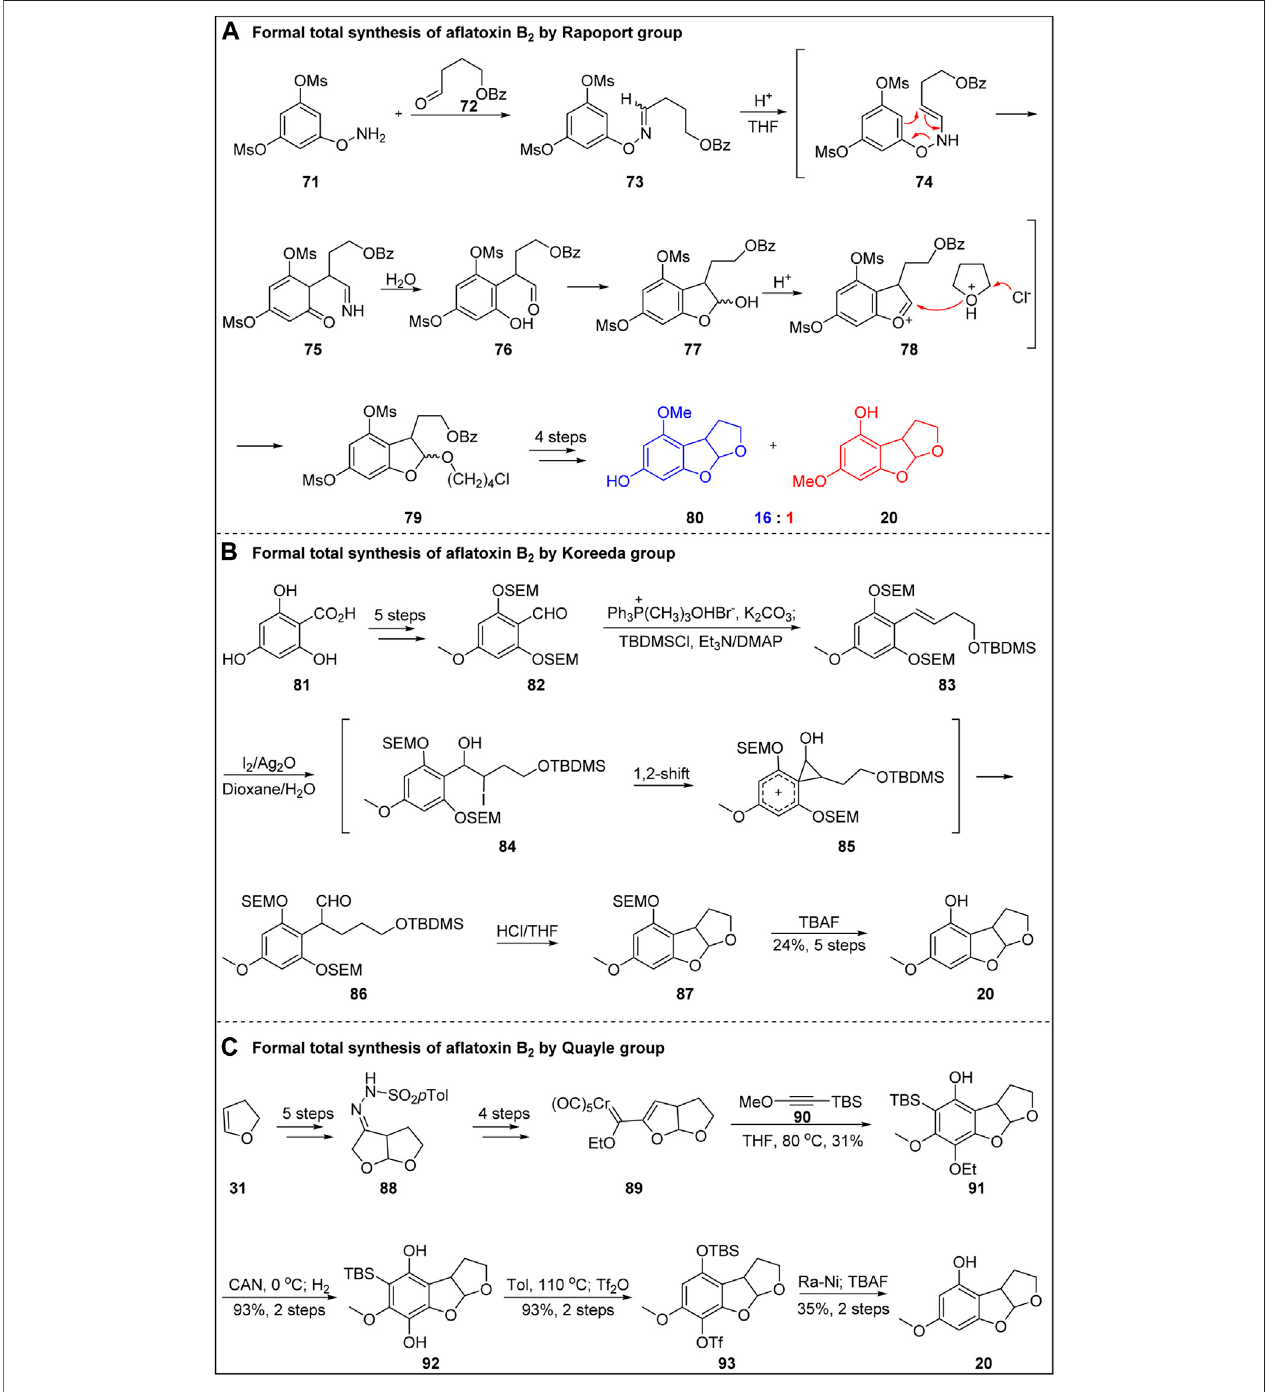
FIGURE 10 | Formal total synthesis of a fl atoxin B